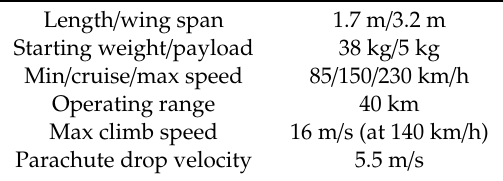
Figure 1. HORNET remotely piloted aerial system (RPAS) in-flight. Table 1. HORNET RPAS basic parameters (min = minimum, max = maximum).